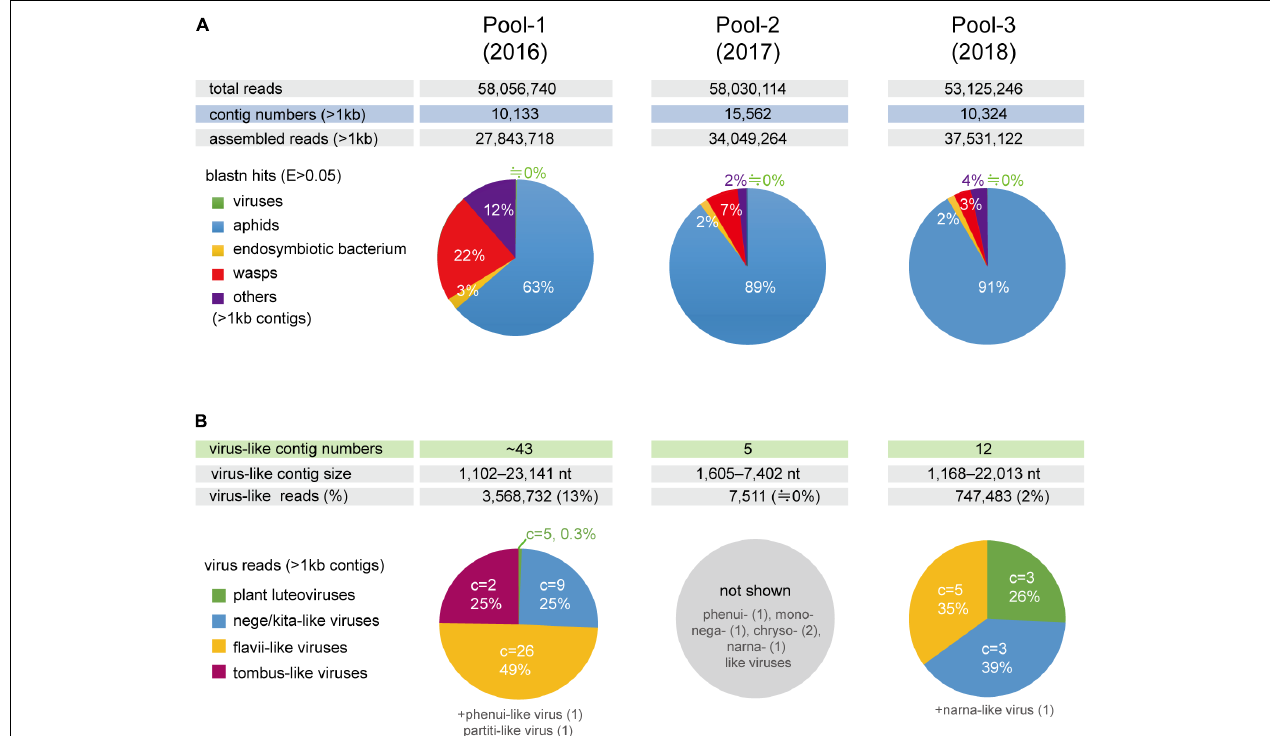
FIGURE 1 | Number of de novo- assembled contig sequences in the three libraries (pools 1–3) derived from the barley aphid transcriptomic analysis using NGS. (A) Distribution of the contigs based on organisms (aphids, parasitoid wasps, endosymbiont bacterium, viruses, and others) analyzed using BlastN matches with an e -Value < 0.05 for the selected reference sequence data (transcriptomic or genomic sequences) (see Section “Materials and Methods”). (B) The number of raw reads mapping to virus-like contig sequences related to different viral groups (families or proposed taxa). Charts show the percentage of raw read, estimated using